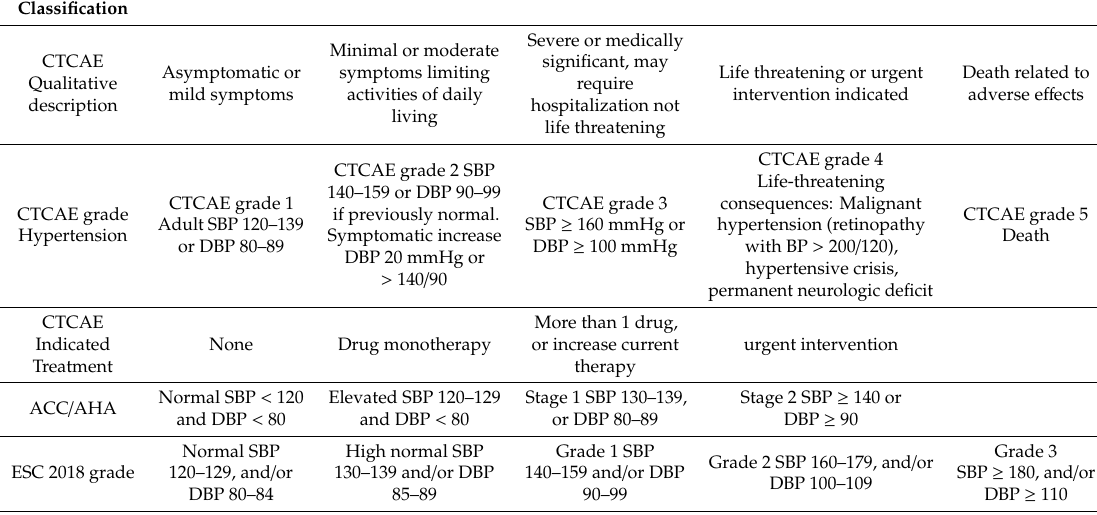
Table 1. Comparison of ACC / AHA [20], ESC 2018 [21] and NCI Common Terminology Criteria for Adverse Events 2017 (CTCAE version 5) [19] classification for